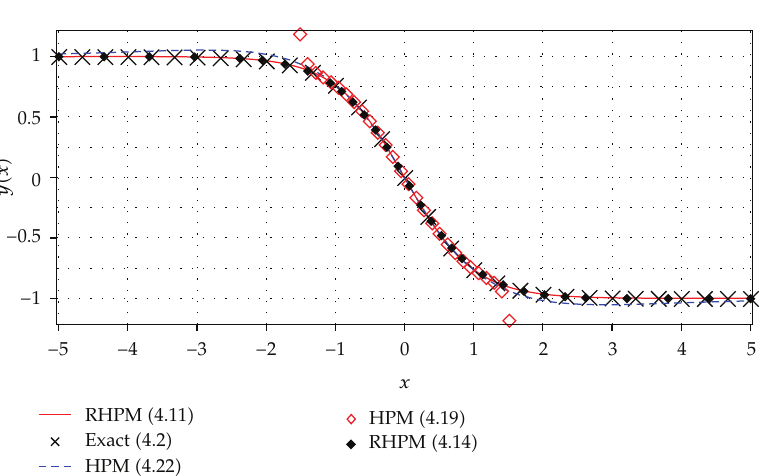
Figure 1: Exact solution (cid:3) 4.2 (cid:4) (cid:3) diagonal cross (cid:4) for (cid:3) 4.1 (cid:4) and its approximate solutions (cid:3) 4.11 (cid:4) (cid:3) solid line (cid:4) , (cid:3) 4.14 (cid:4) (cid:3) solid diamond (cid:4) , (cid:3) 4.19 (cid:4) (cid:3) empty diamonds (cid:4) , and (cid:3) 4.22 (cid:4) (cid:3) dashed (cid:4) .